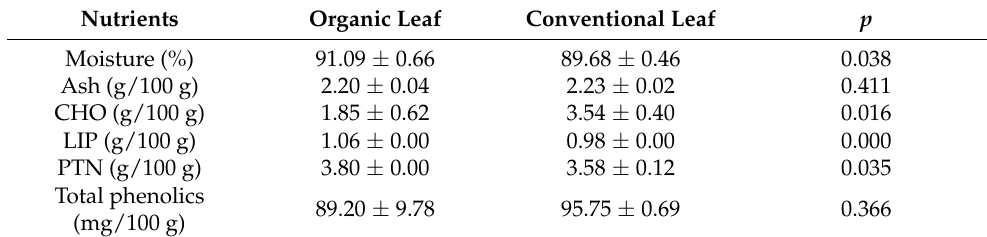
Table 1. Nutritional composition of organic and conventional leaves. Nutrients Organic Leaf Conventional Leaf p Moisture (%)